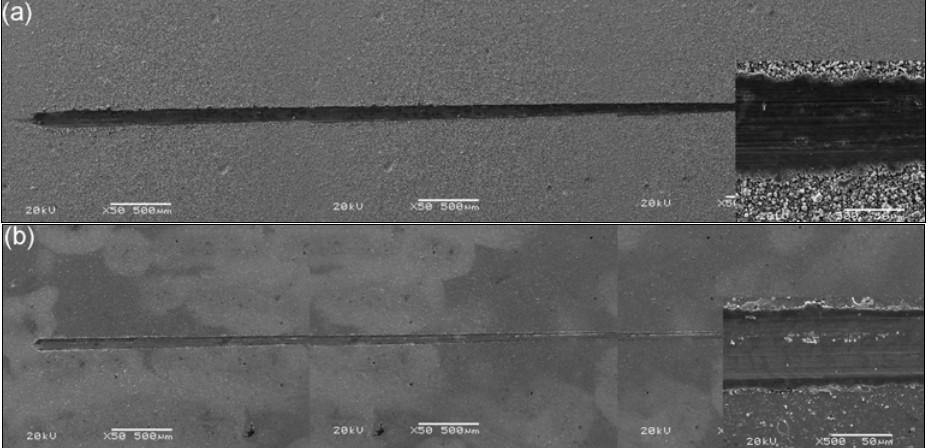
Figure 11. SEM images of scratch traces of TiAlN films: a) The smallest adhesion, b) The largest